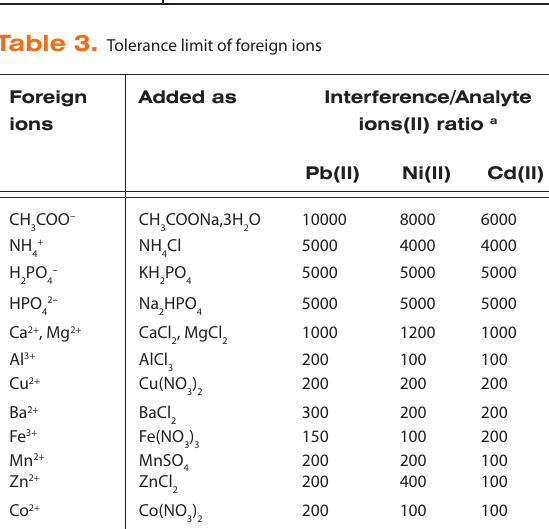
Table 3. Tolerance limit of foreign